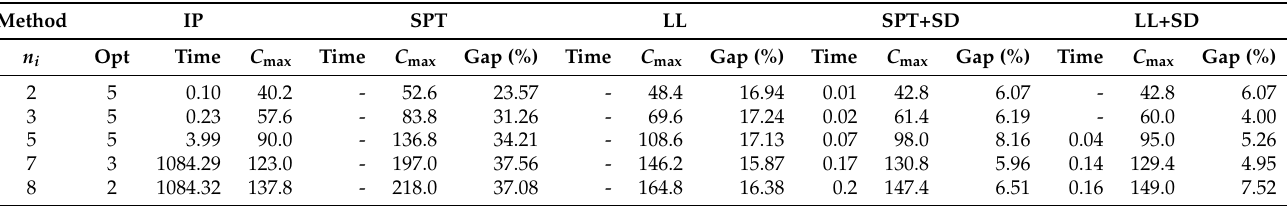
Table 1. Results for s i ∈ [ 1,10 ] and p i ∈ [ 1,20 ]